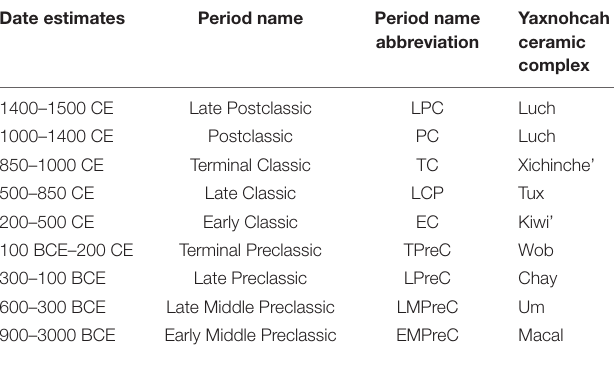
TABLE 1 | Yaxnohcah chronology based on ceramic complexes (after Reese-Taylor, 2017, Table 15.1).